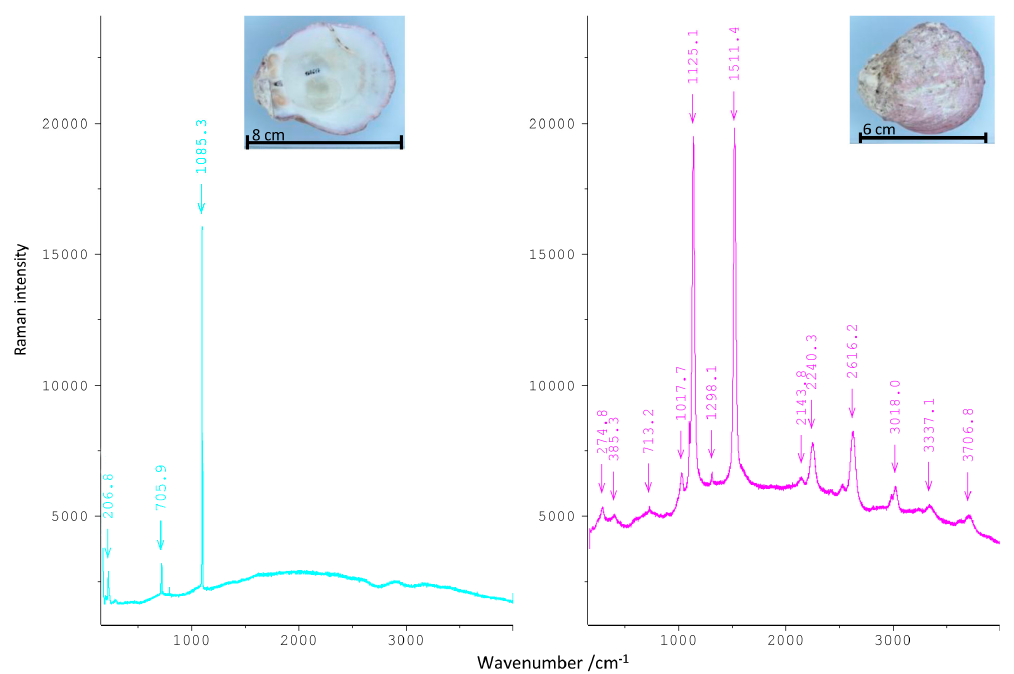
Figure 14. Raman spectra of Spondylus gaederopus from Morea, Greece, taken with 532 nm (diode). Left: